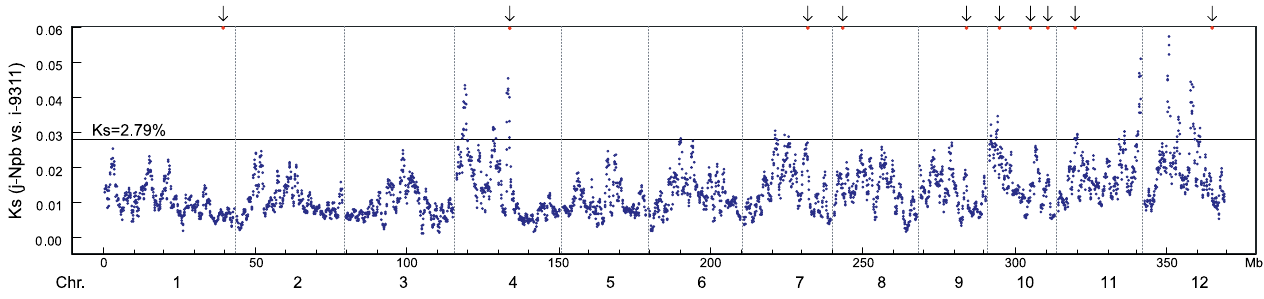
Figure 1. A Sliding Window Presentation of the Mean Ks Values between j-Npb and i-9311 for Genes in Each 1-Mb Segment The step size is 0.1 Mb. Each Ks value is obtained from the concatenated sequences within the segment. The horizontal line is the cutoff at Ks ¼ 2.79% (see text). Arrows on the top indicate the positions of high polymorphism genes used in Table 2. Only half of them were chosen from large clusters of high polymorphism genes ( . 1 Mb). A parallel presentation that adjusts for variation in mutation rate across the whole genome is given in Figure S2.